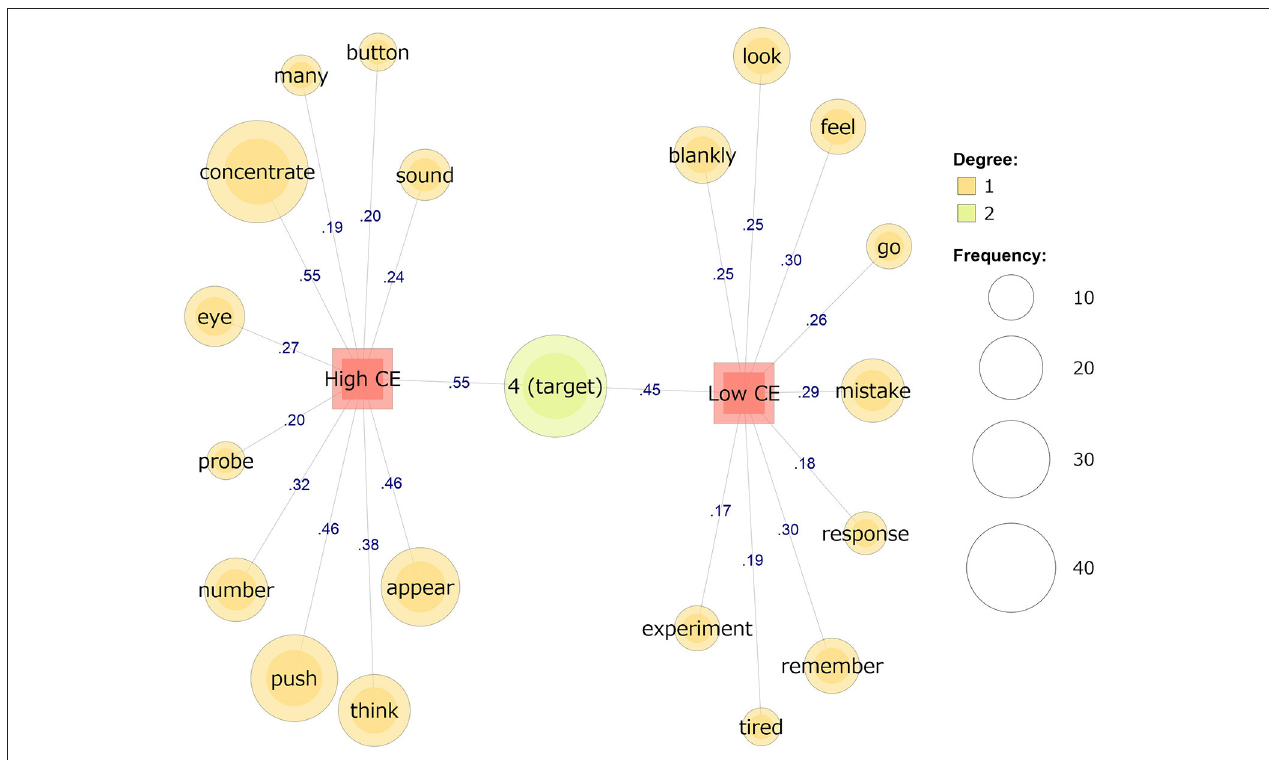
FIGURE 2 | Comparison of the co-occurrence networks for self-reported mind wandering between the high ( n = 29) and low ( n = 24) groups for coping-with-emotion skills. The values on the line are Jaccard coefficients.